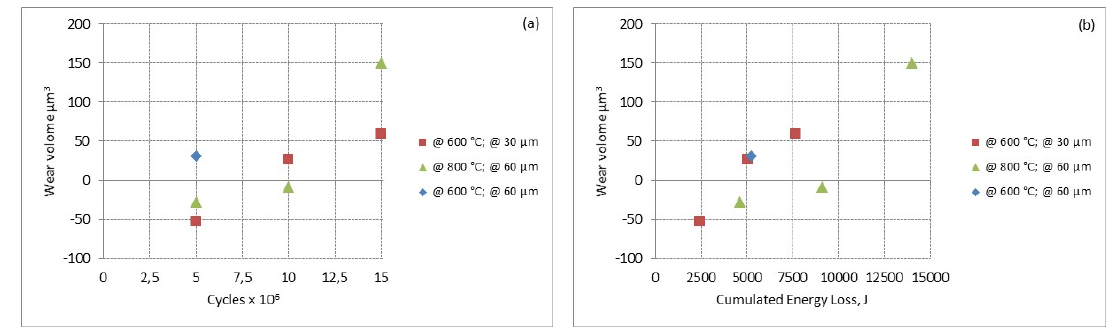
Figure 8. Wear volume as a function of wear cycles ( a ) and cumulated energy loss ( b ).